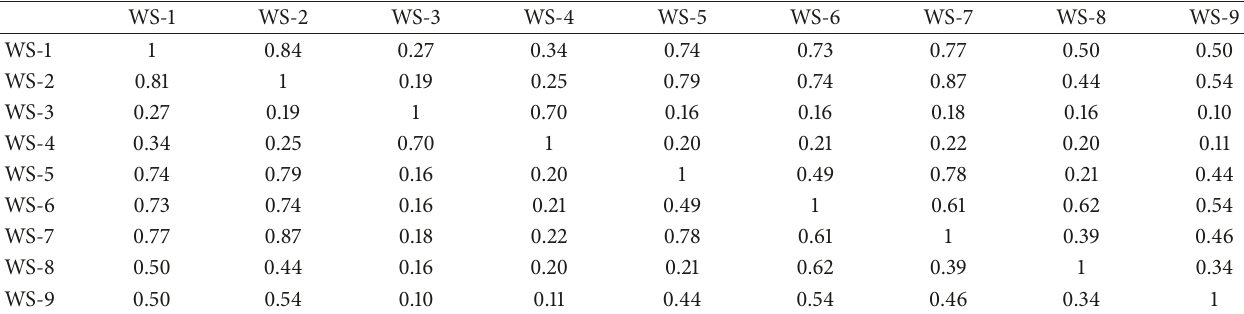
Table 3: Linear correlation coefficients between the wind speeds recorded at the different weather